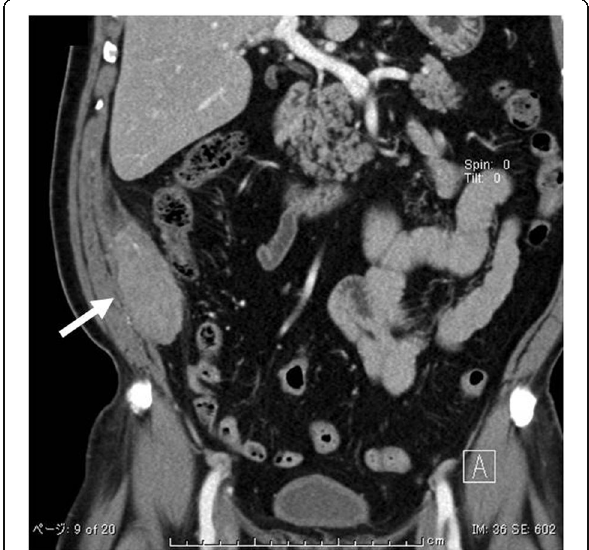
Fig. 2 Helical computed tomography (CT) indicating a solid mass in the abdominal wall (arrow)